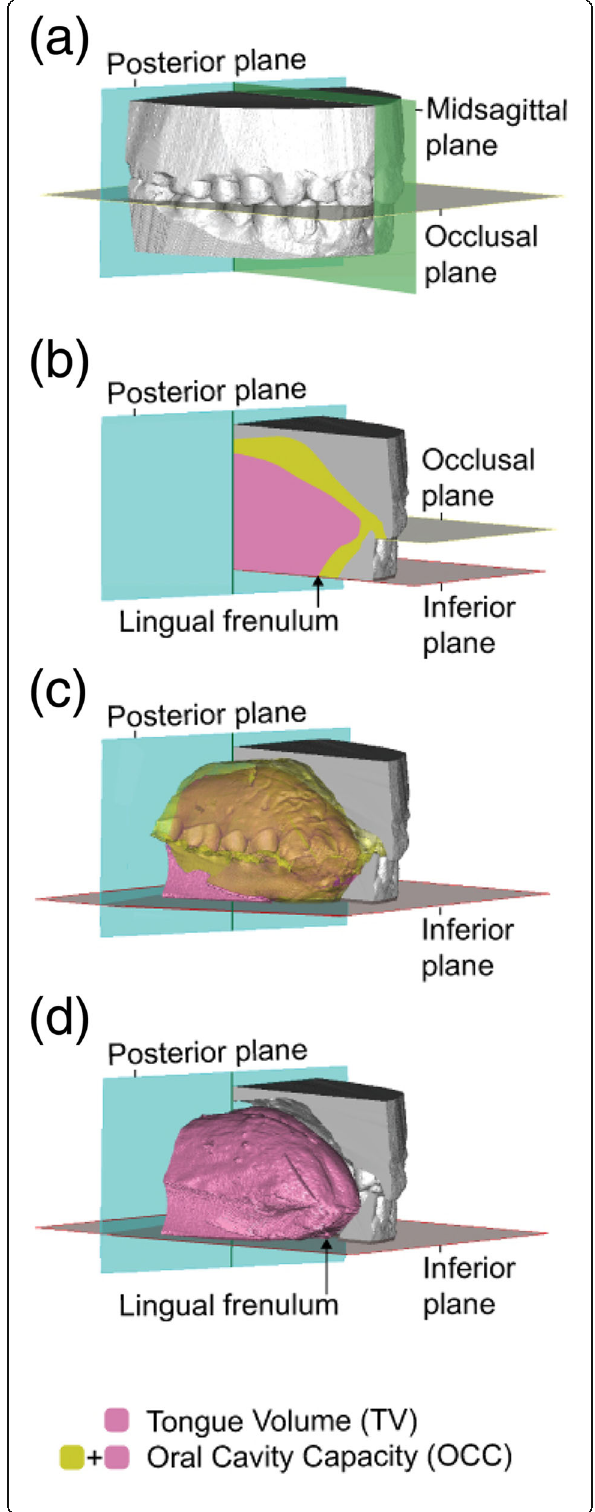
Fig. 3 Definition of the measurement area of OCC and TV. a The occlusal plane (gray) was defined as the plane passing through the central cusp of the lower first molars and the incisal edge of the right central incisor. The posterior plane (blue) was defined as the plane passing through the distal cusp of the upper second molar perpendicular to the occlusal plane. b The inferior plane (red) was defined as the plane passing through the lingual frenulum parallel to the occlusal plane. c The oral cavity capacity (OCC) was defined as the space surrounded by the upper and lower dental arches, palate, posterior plane, and inferior plane (yellow). d Tongue volume (TV) was defined as the area of the tongue within OCC (pink plus